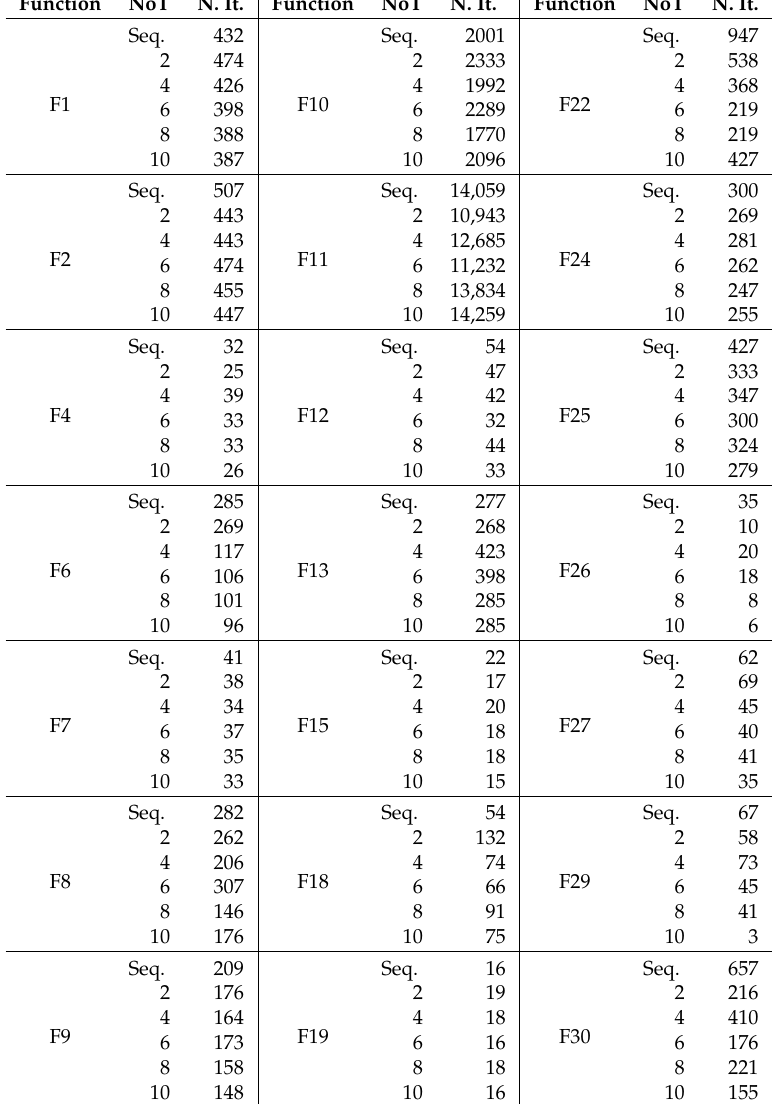
Table 9. Average number of function iterations for SPP_TLBO, Runs = 30, Subpopulation size = 120. Function NoT N. It. Function